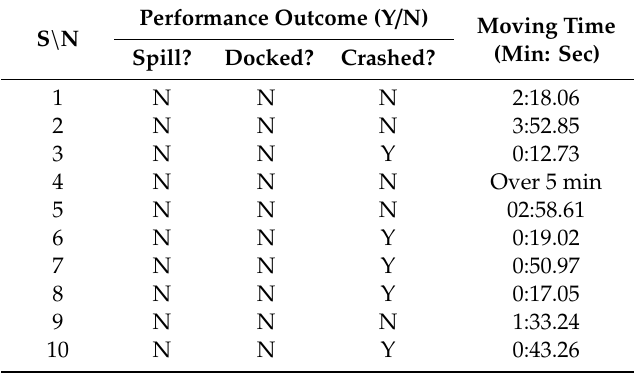
Table 1. Results of using ramp velocity